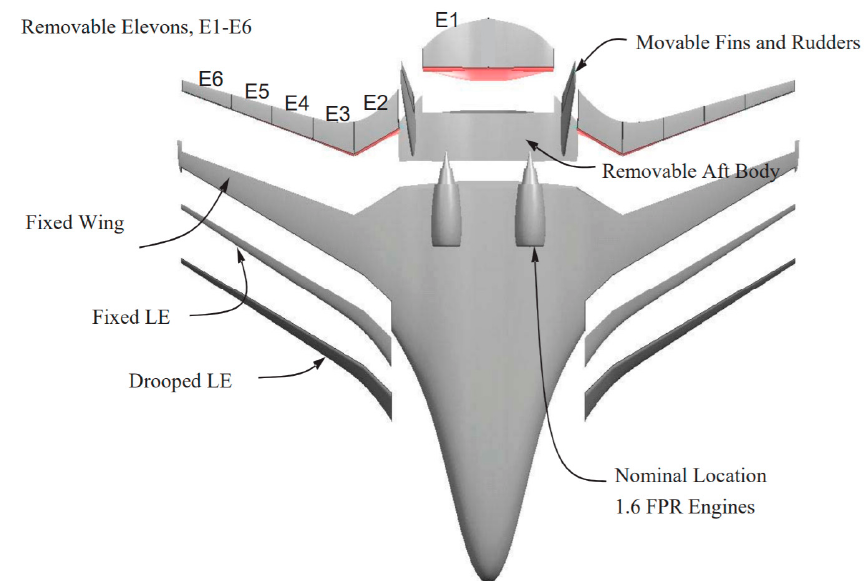
Figure 4. General Hybrid Wing Body (HWB) configuration (Ref. [24]).